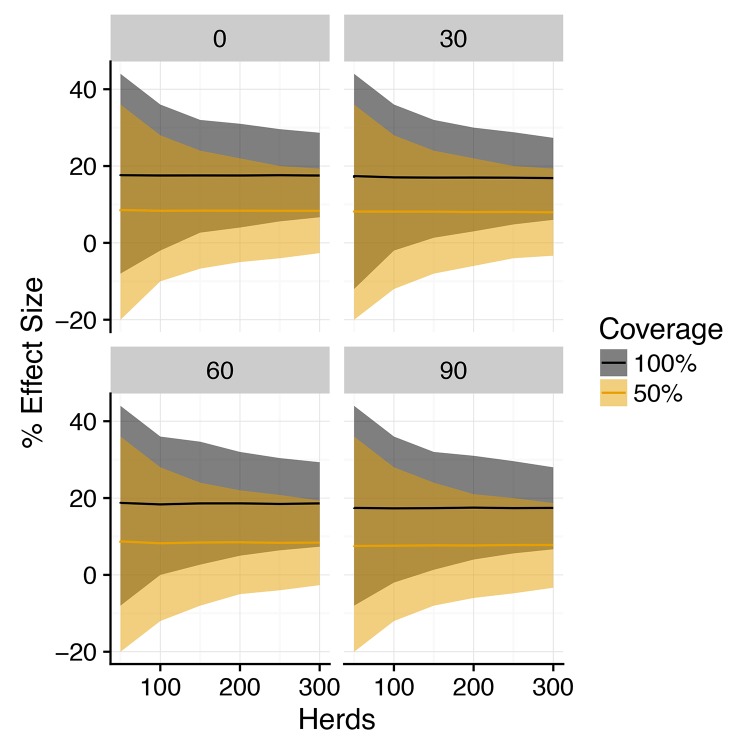
Posterior predictive distribution for effect size of vaccination on duration of restrictions (SORI model).Posterior predictive distribution of the % difference in the probability of a prolonged breakdown (effect size) between vaccinated and control herds for a 3-year trial duration for the SORI model plotted against herd size. Median value is plotted as a solid line, with shaded region illustrating 95% credible intervals for 100% within-herd target coverage of vaccination (black) and 50% target coverage (orange). Plotted distributions are for an assumed reduction in susceptibility of εS=60% and the reduction in infectiousness εI as indicated in the heading of each panel.